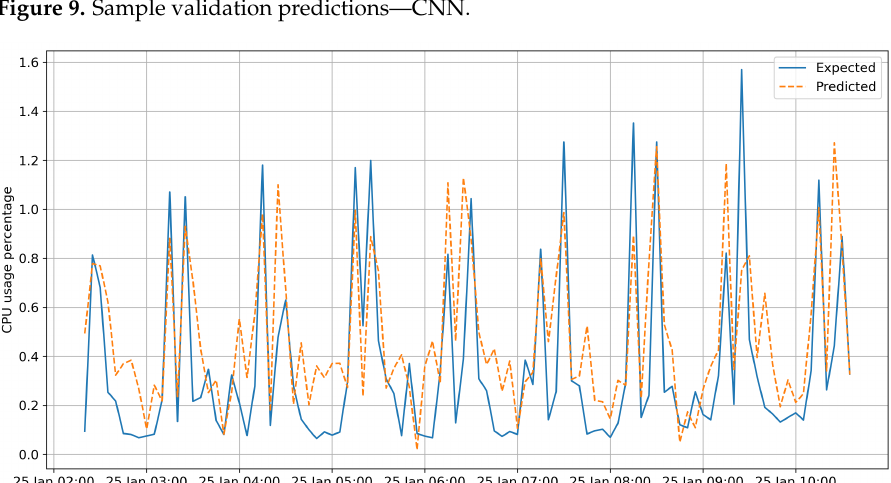
Figure 9. Sample validation predictions—CNN.